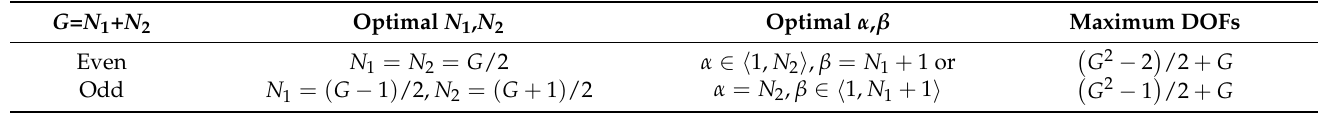
Table 1. Optimal configuration and maximum DOFs for GNA-DCA.